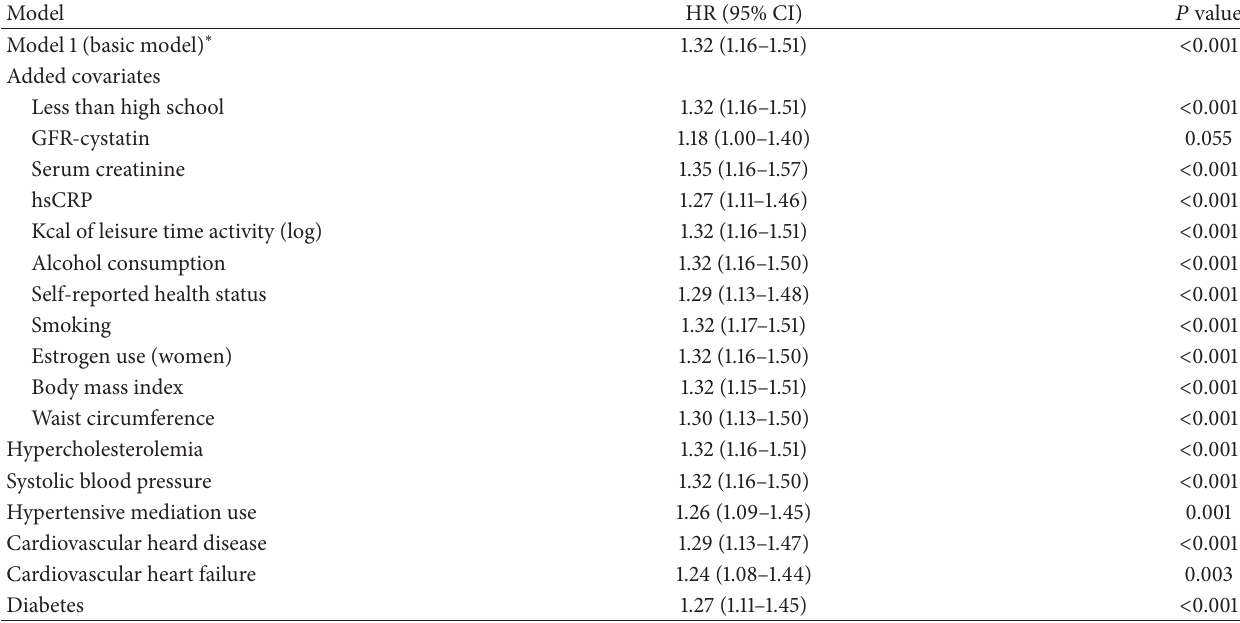
Table 3: Effect of each covariate added one at a time on the hazard ratio (95% CI) of SCD per standard deviation (18.98ng/mL) increase in